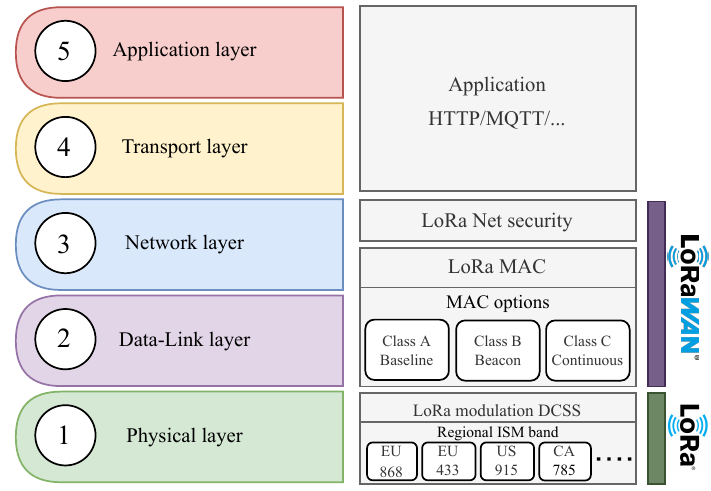
Figure 13. Comparing LoRaWAN stack with OSI